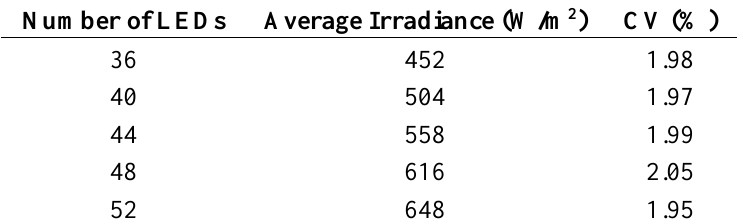
Figure 10. Pareto front for 36, 40, 44, 48 and 52 LEDs. The CV limit of 2% is given by the horizontal line. Table 5. Average irradiance at CV = 2% for different number of